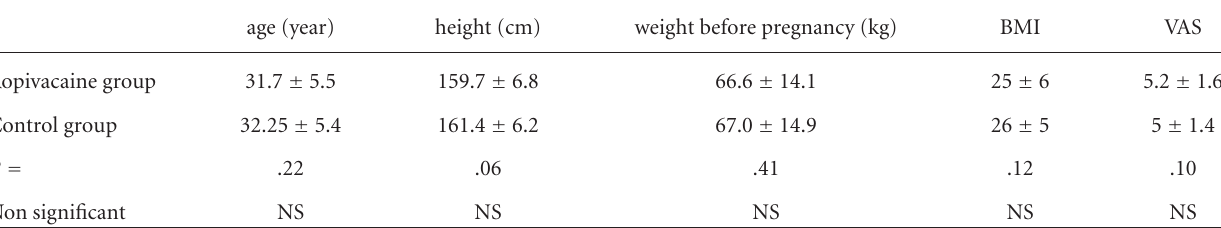
Table 1: Parturient’s demographics and VAS scores evaluated every 2 hours.